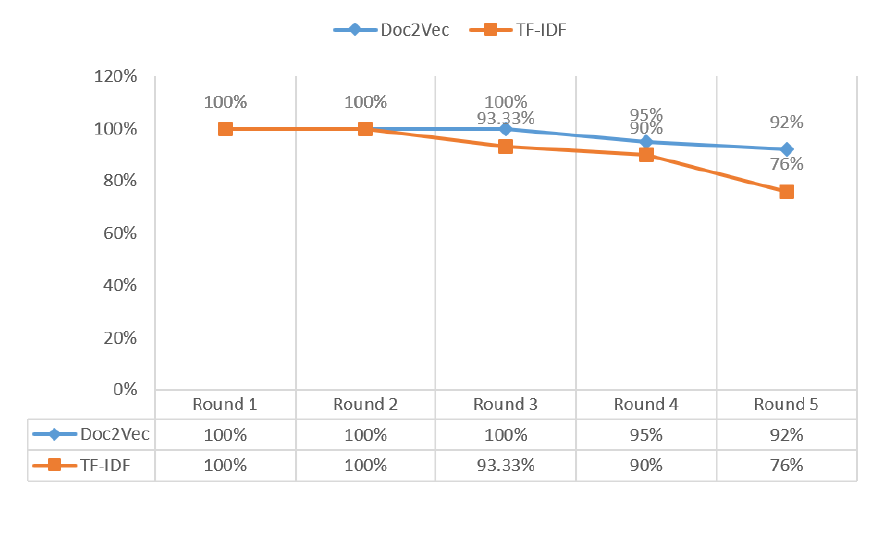
Figure 15. Learning Ability of TF-IDF and